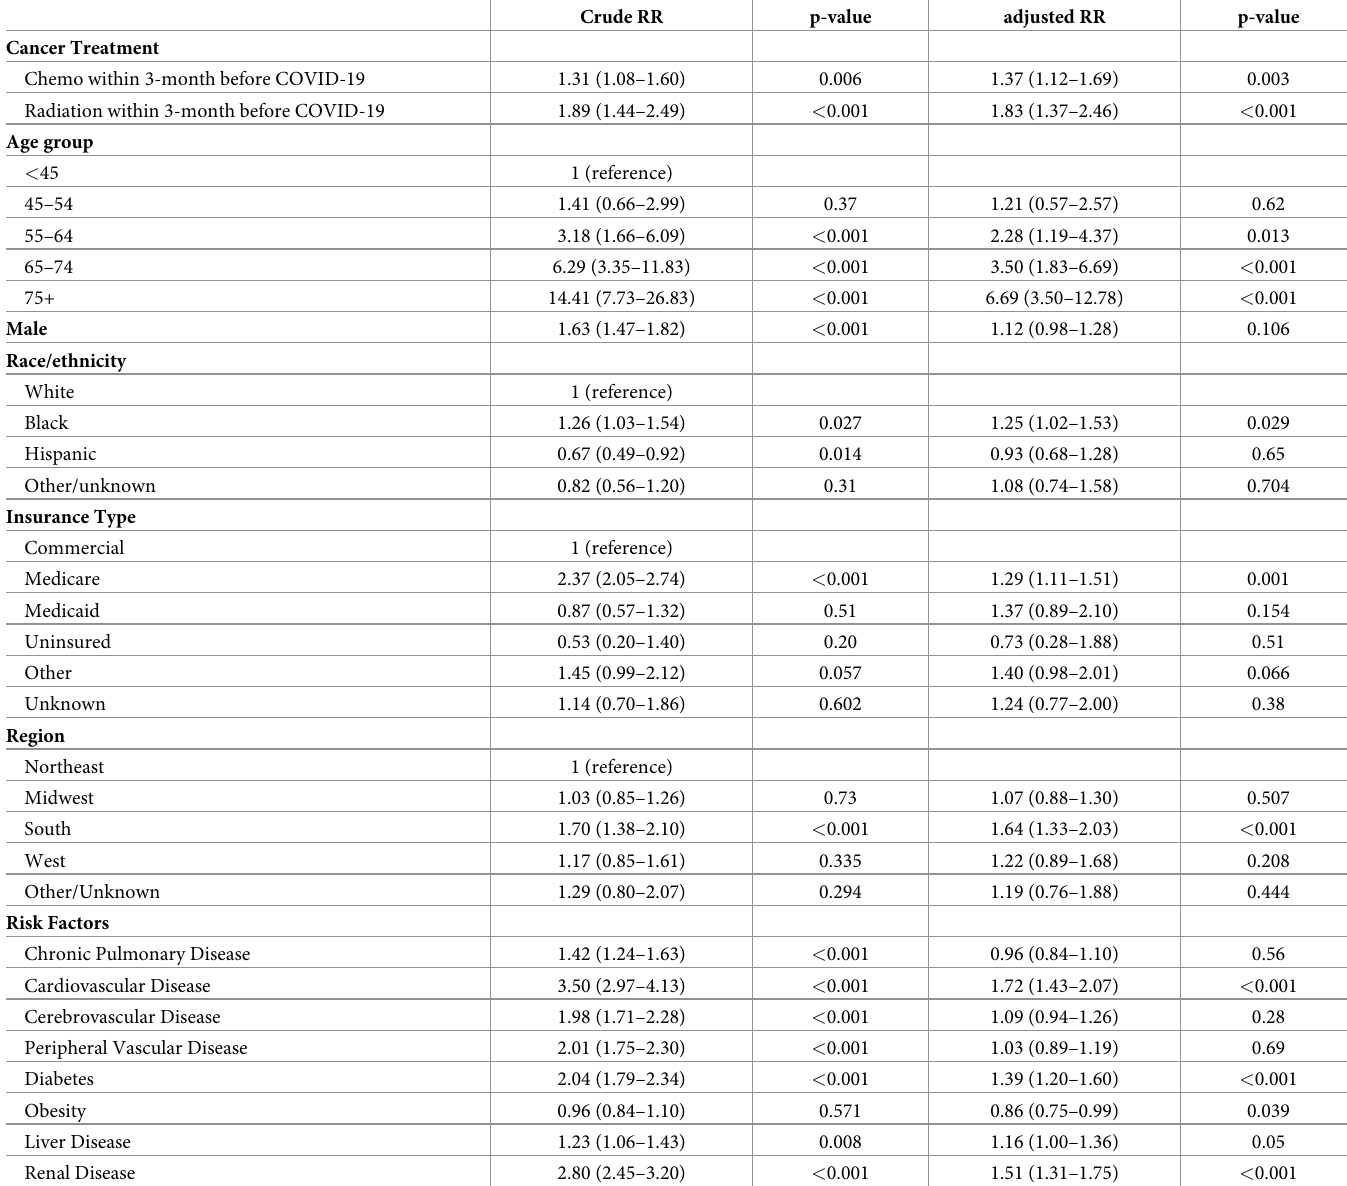
Table 3. Factors associated with the mortality in COVID-19 with recent